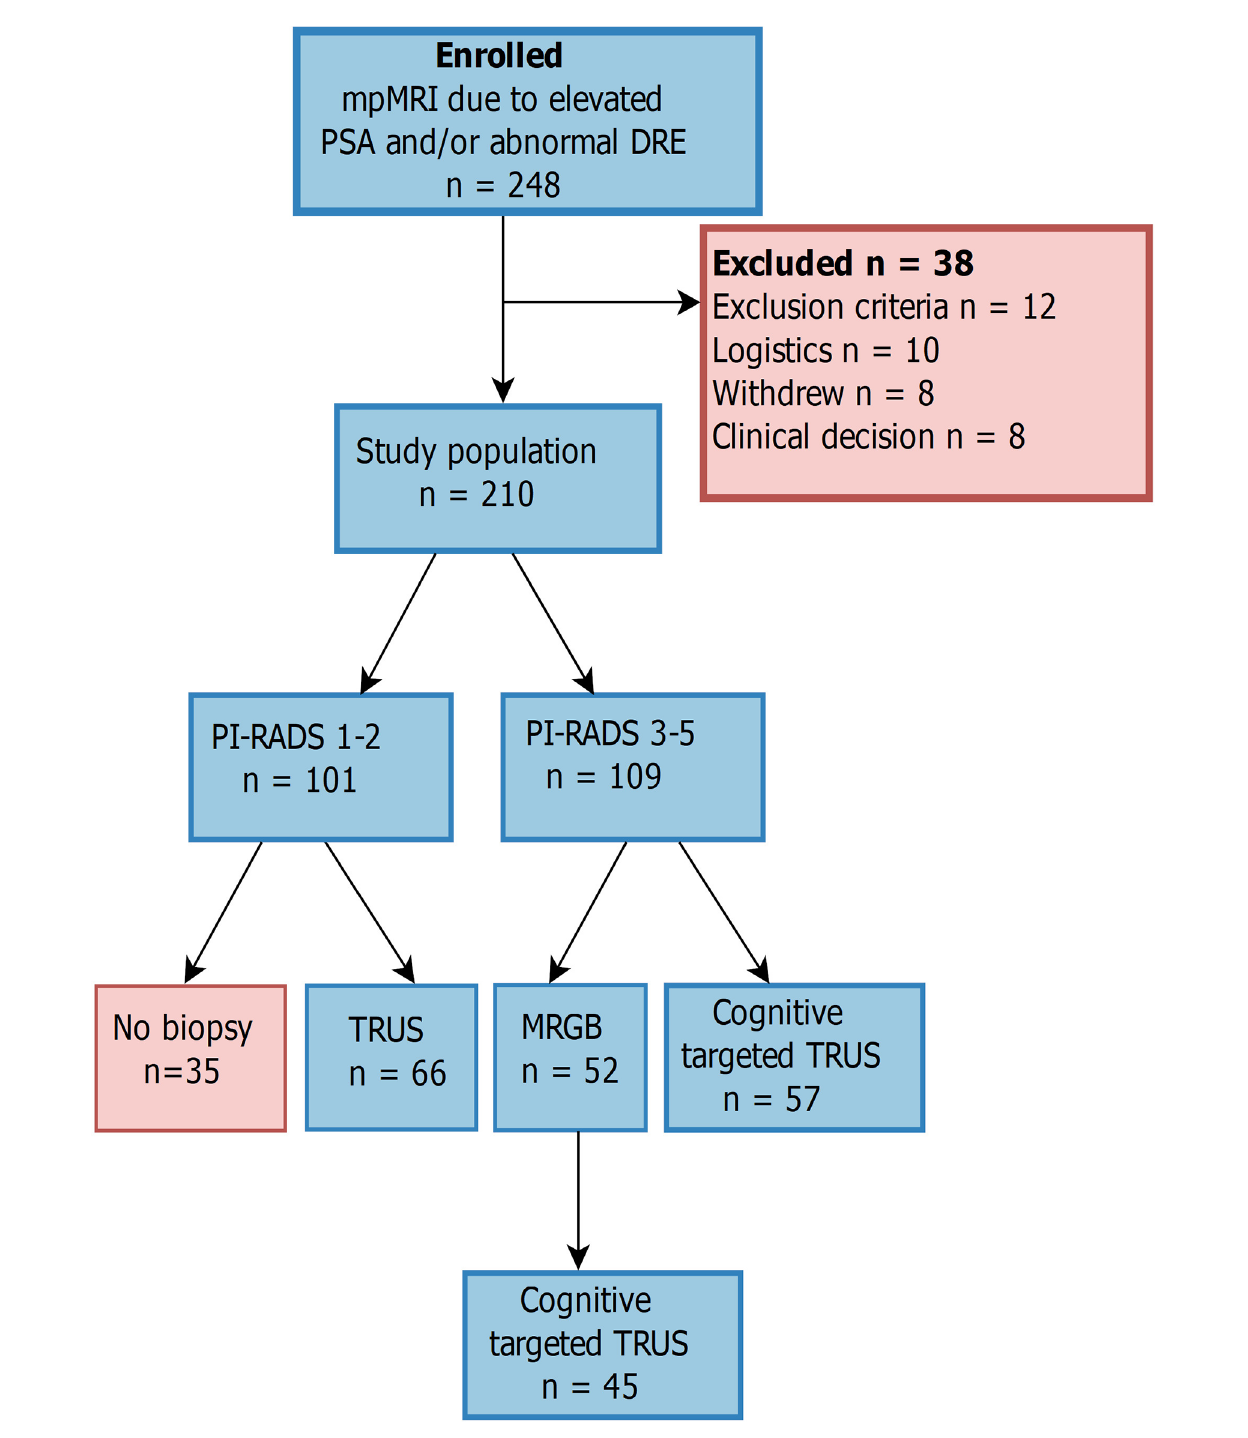
FIGURE 1 | Study design. No absolute cutoff was used for elevated prostate-speci fi c antigen, and a total of 210 men were included in the fi nal analysis. mpMRI, multiparametric MRI; PI-RADS, Prostate Imaging Reporting and Data System; MRGB, MR-guided in-bore biopsy; TRUS, transrectal ultrasound-guided biopsy; Cognitive targeted TRUS, cognitive targeted TRUS biopsies with additional systematic biopsy cores.